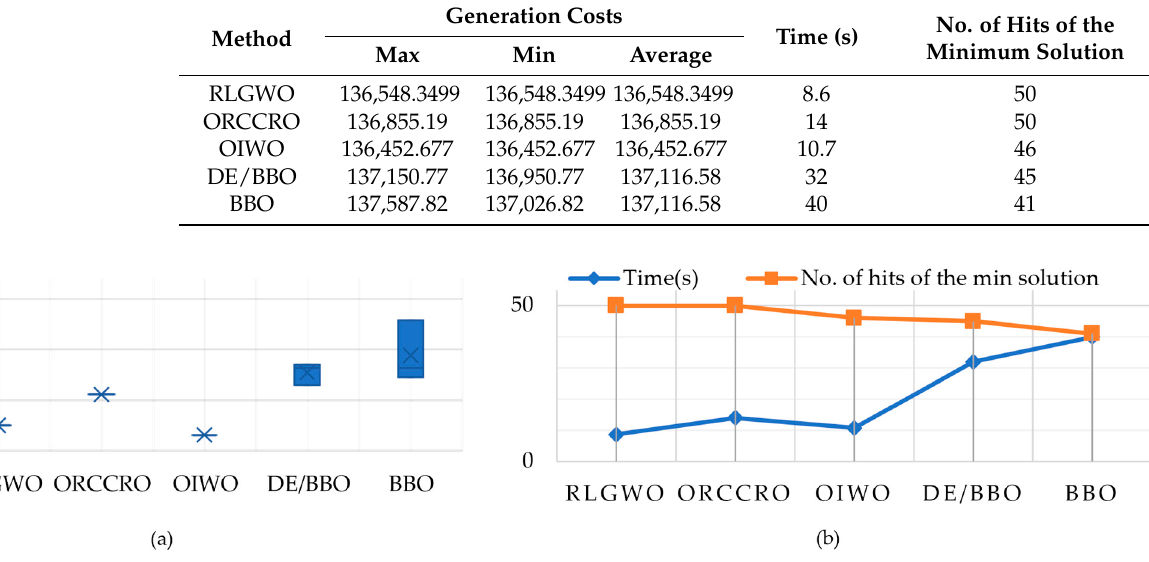
Figure 7. Results for different methods for the 40-unit system (50 trials): ( a ) boxplot of the final generation cost; ( b ) time and number of hits of the minimum solution.